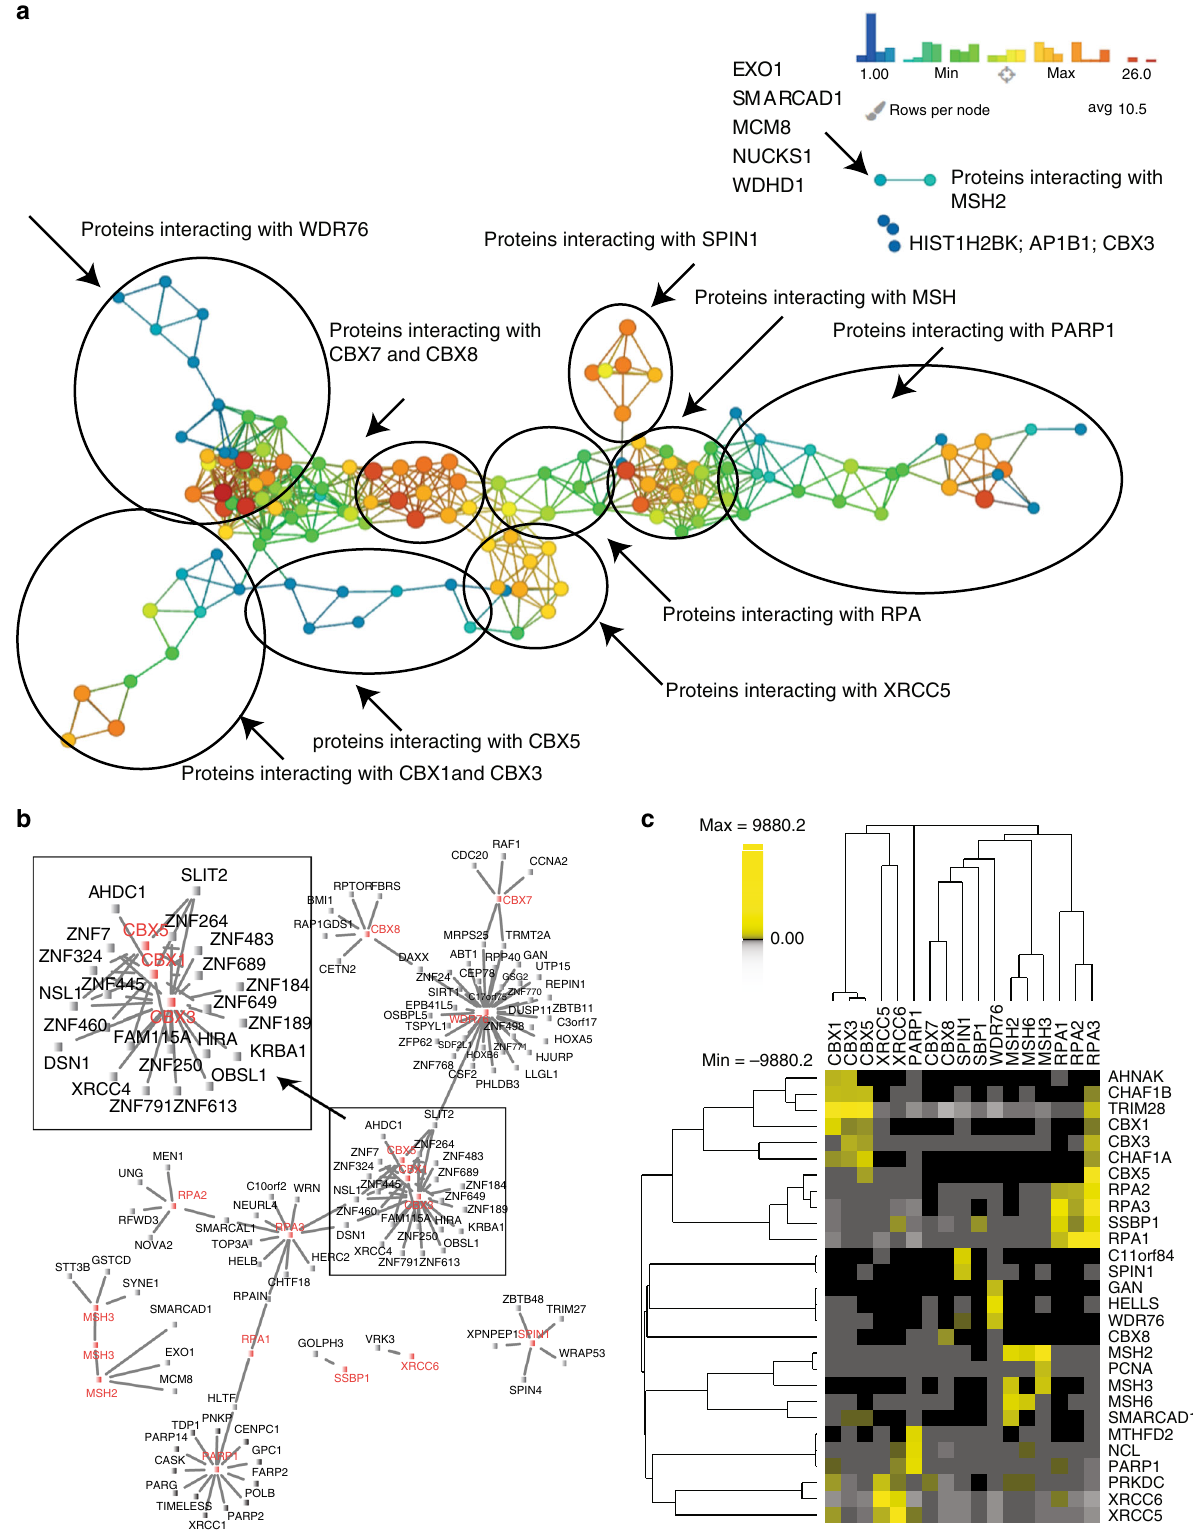
calculated for XRCC6 in the XRCC5 af fi nity puri fi cation, which is a known heterodimer 13 , led us to investigate the TopS approach in the well-characterized yeast chromatin remodeling system. We have previously utilized deletion network analyses to determine the modularity of the INO80 14 and SWI/SNF 12 chromatin